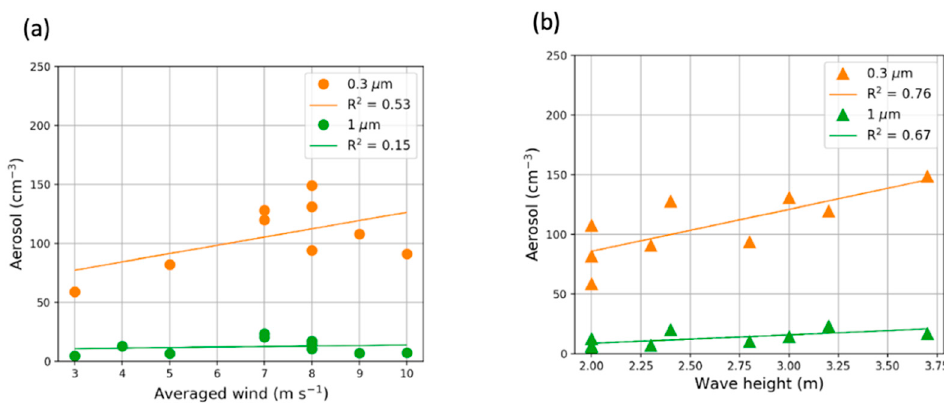
Figure 16. Aerosol concentrations (diameter >0.3 µ m and >1.0 µ m) measured during the BOREAL flights as a function of ( a ) the averaged horizontal wind in the marine boundary layer and ( b ) the measured wave height.